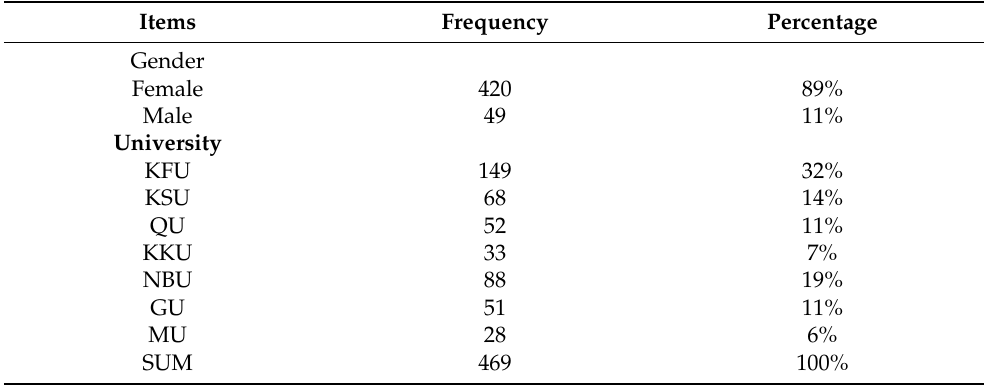
Table 2. Sample of the